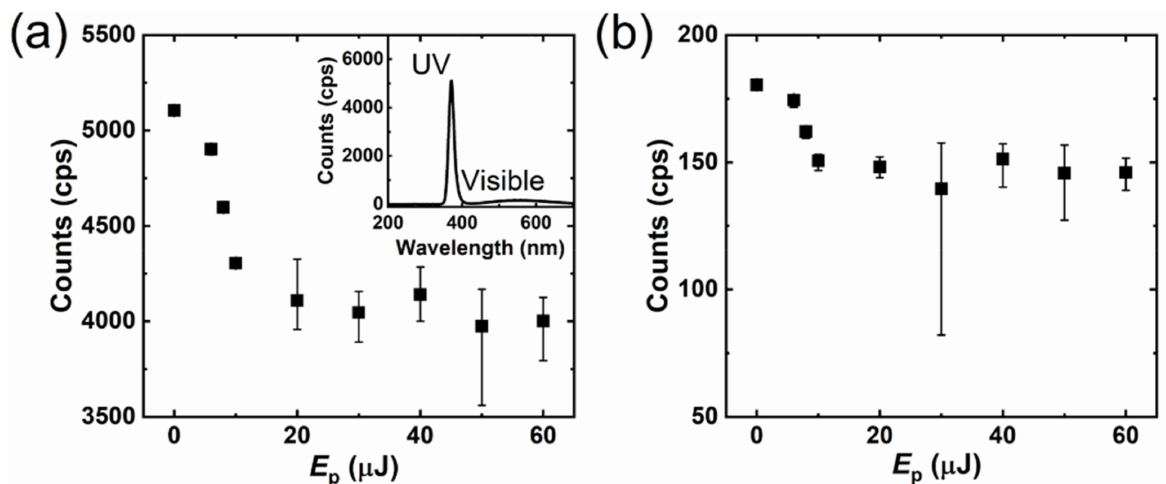
Figure 8. The intensities of the UV ( a ) and green-light ( b ) luminescence of the one-pulse irradiated spots. The error bar using minimum and maximum was obtained from five samples. The inserted graph shows the CL spectrum of the unprocessed ZnO surface whose index is 0 J in graphs ( a , b